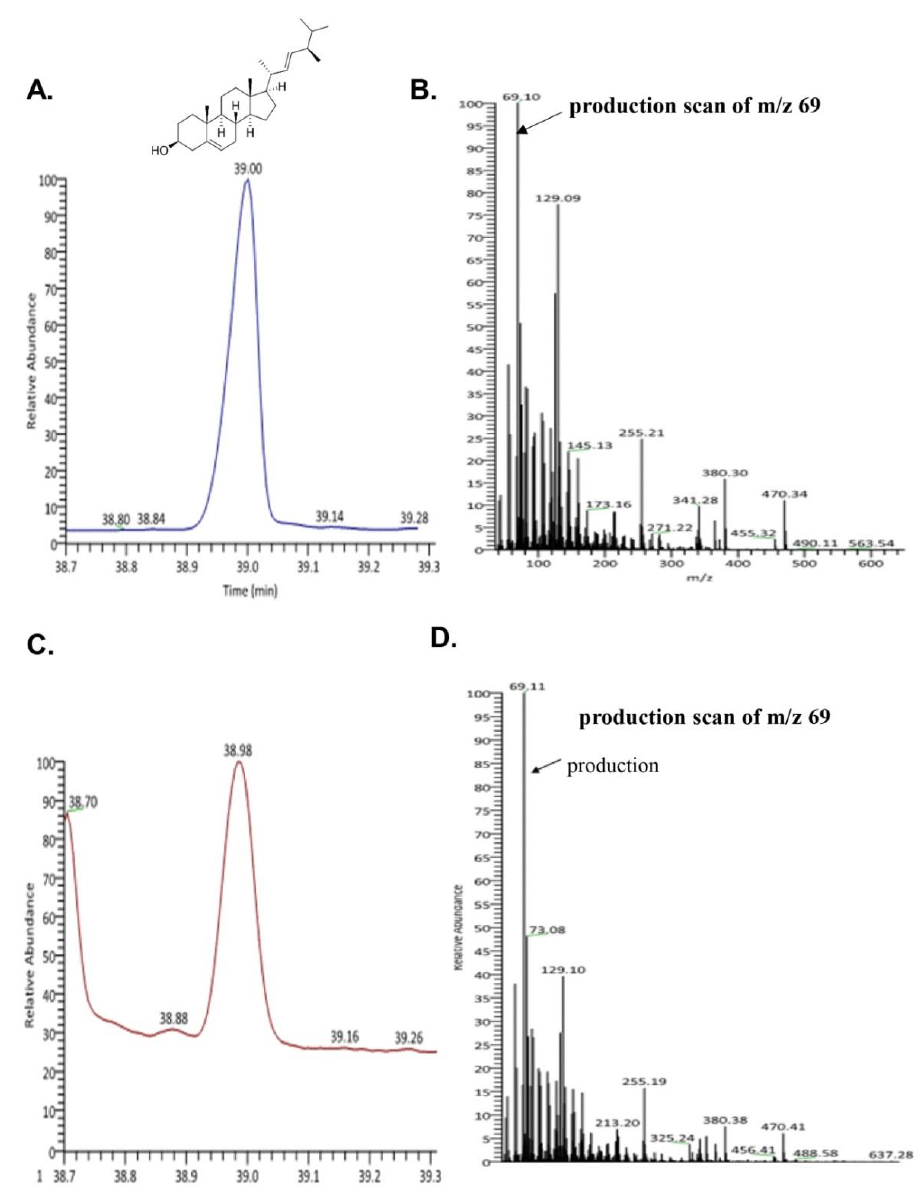
Figure 2. Ion chromatogram of trimethylsilyl derivatives of acidic components and ass spectra by GC / MS analysis of ( A ) total ion chromatogram of brassicasterol; ( B ) mass spectra of brassicasterol; ( C ) total ion chromatogram of lipid extraction from Hippocampus abdominalis (SHL); ( D ) mass spectra of lipid extraction from Hippocampus abdominalis (SHL).